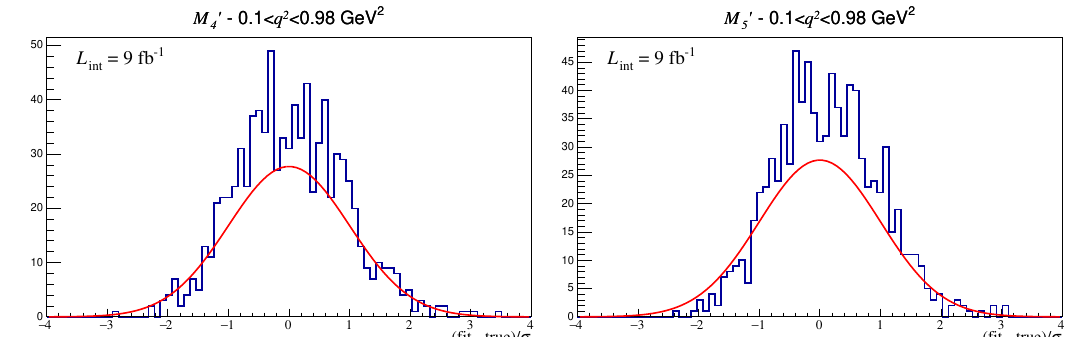
Figure 17 . The pull distributions for the optimised P-wave observables (left) M 0 from pseudoexperiments with the expected LHCb Run 2 yields. The overlaid red curve is a reference of the ideal distribution for the pulls, a Gaussian function with σ = 1